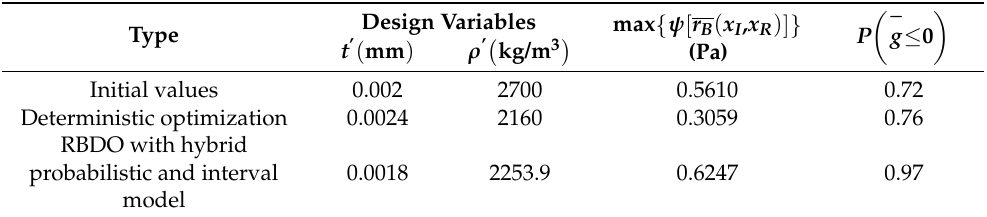
Table 6. Comparison of optimization results obtained by the proposed RBDO method and determin- istic